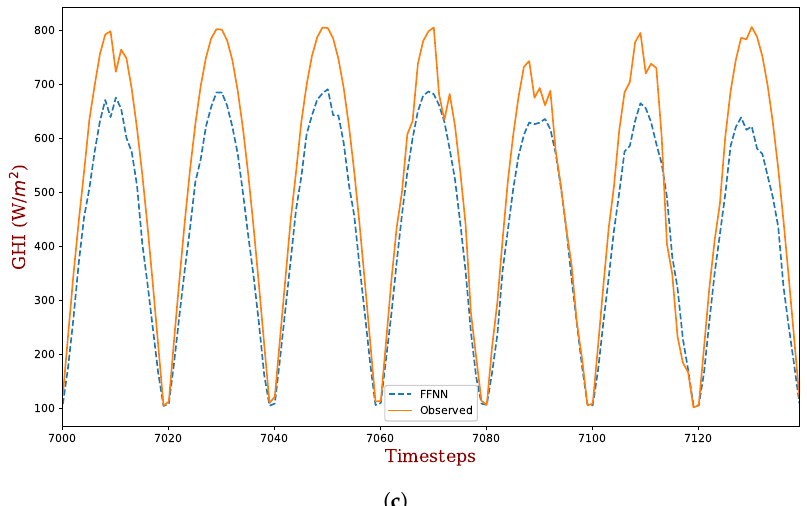
Figure 13. Prediction for three weeks of 2020 with FFNN. ( a ) Week 16 FFNN. ( b ) Week 33 FFNN. ( c ) Week 51 FFNN.